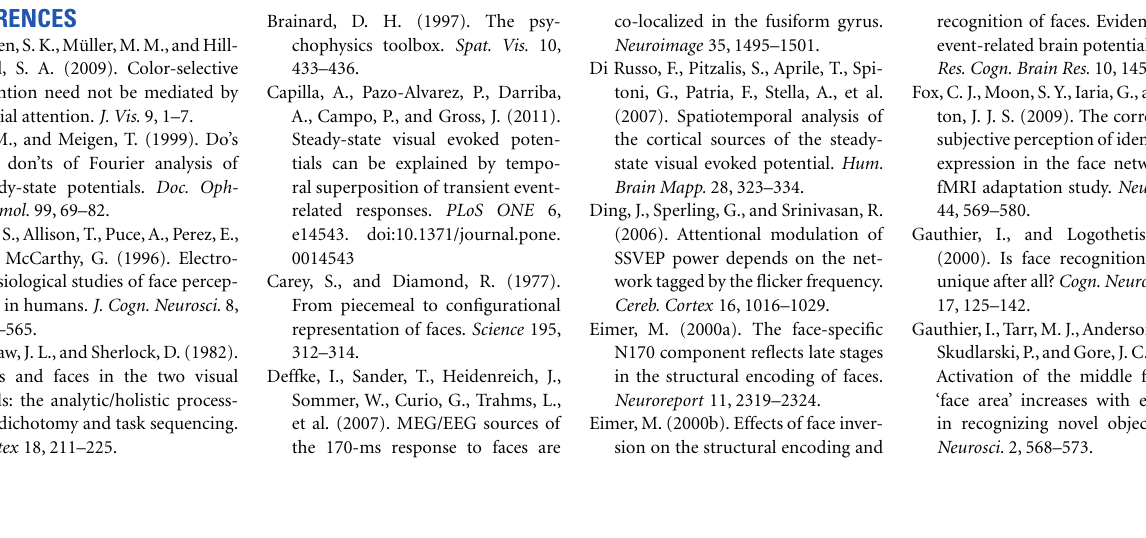
examine the effects of contrast changes in the upper versus